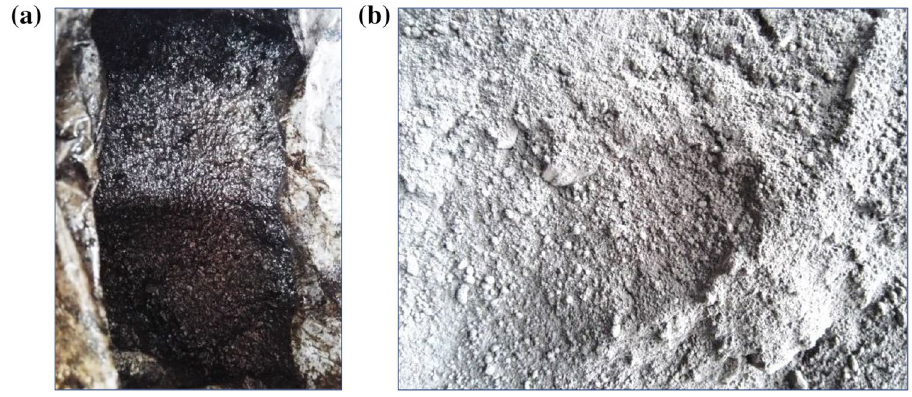
Fig. 3 Sample appearance ( a raw samples; b treated